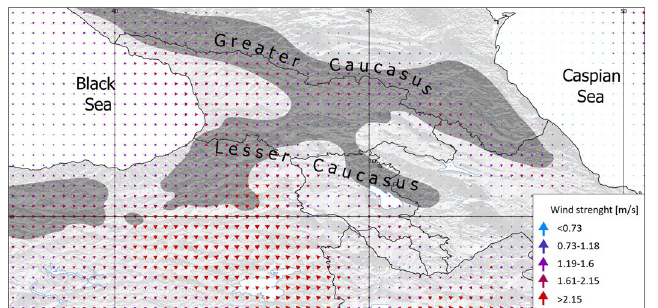
Figure 9. Wind pattern in the Caucasus ecoregion in May (the flowering period of Scots pine) in the period 2000–2012. The arrows indicate the direction of the wind currents while the colour and size indicate the strength. W indscape R package 93 was used for data on wind currents, available in Climate System Forecast Reanalysis with a resolution of c. 35 km 50 . Figure generated with QGIS 3.16 (https:// qgis. org/ en/